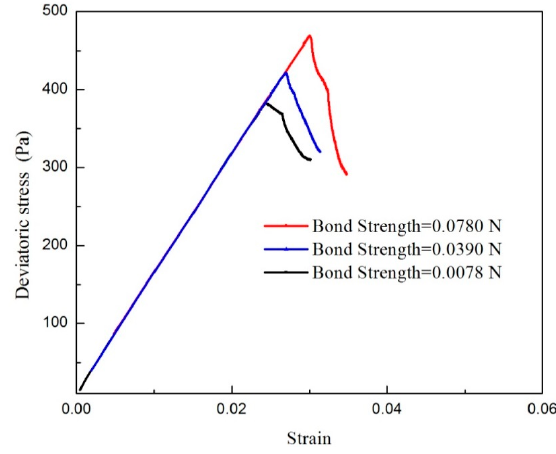
Figure 6. The deviatoric stress–strain responses of cemented granular media in biaxial compression simulation.